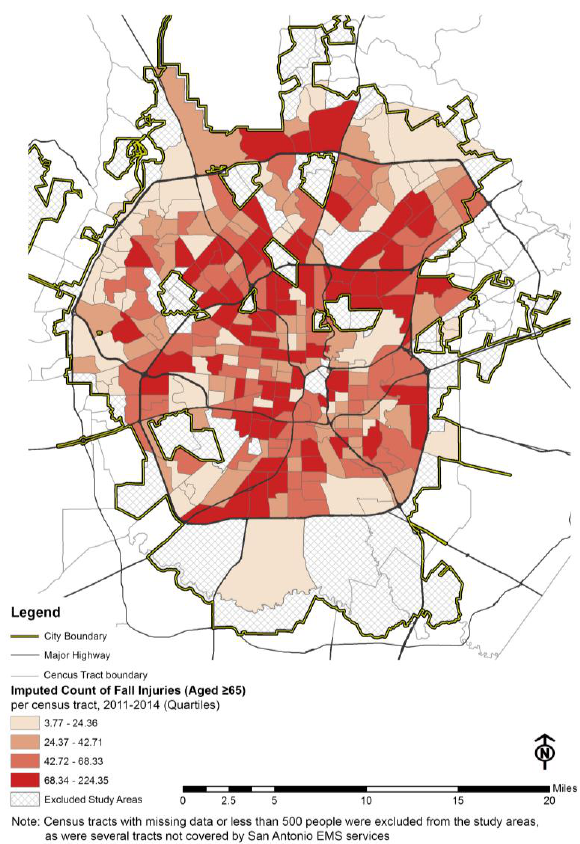
Figure 1. EMS recorded fall-related injuries (aged ≥ 65) per census tract, city of San Antonio, 2011–2014.